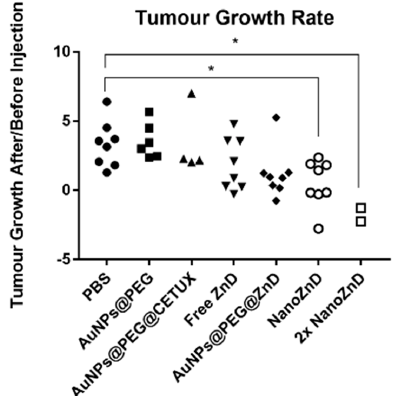
Figure 7. Tumor growth rate in mice model. Ratio of tumor growth rate before (T0) and after injection of formulation (T1 or T2). Each point represents one injection. Values greater than one represent an increase in the tumor growth rate after injection. Values between one and zero represent a decrease in the tumor growth rate. Negative values indicate not only decrease a in the tumor growth rate, but also tumor remission (* p < 0.05).